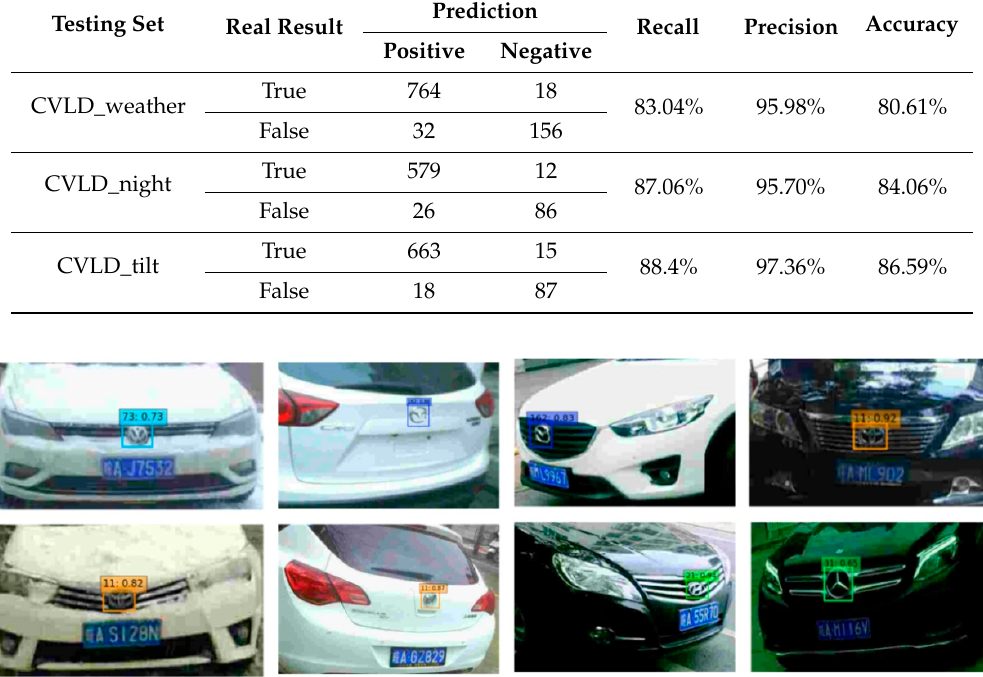
Figure 10. Success examples under complicated environments.